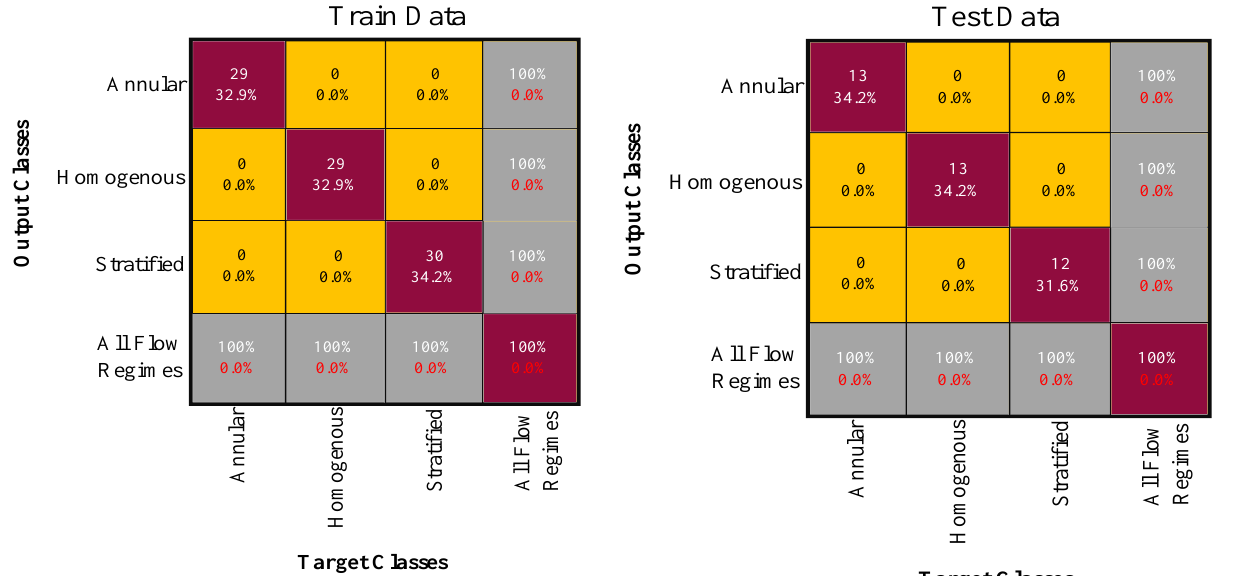
Figure 8. Performance of the classifier network.